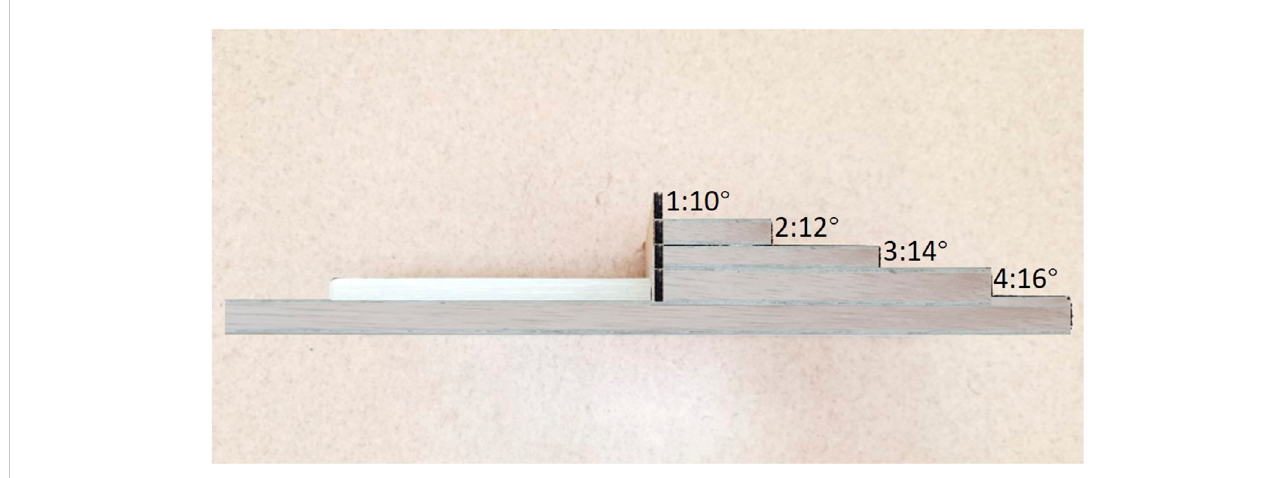
Lateral view of the physical stops that were slid in and out to generate the four possible ankle inversions of 10, 12, 14, and 16 ° .